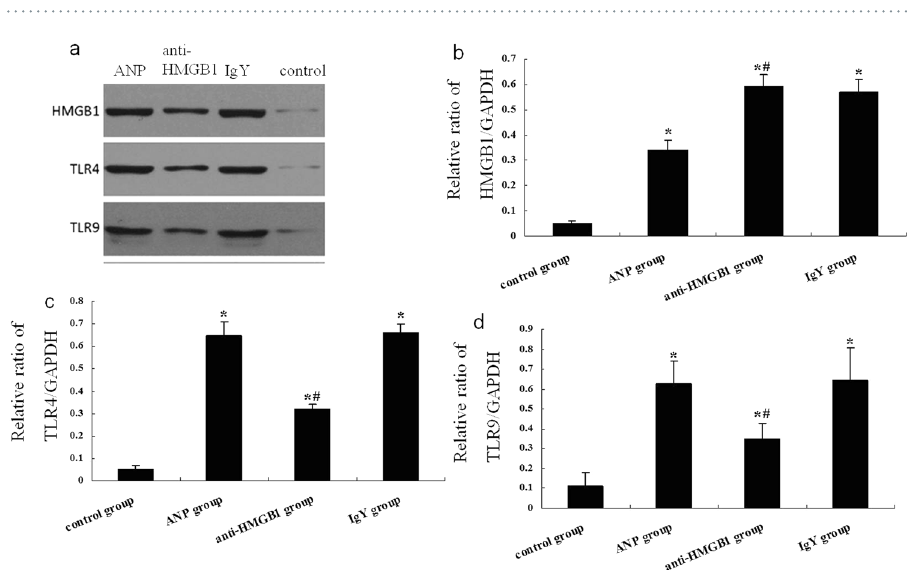
Figure 8. Anti-HMGB1 antibody treatment suppresses the elevated expressions of TLR4, TLR9 protiens. ( a ) Western blot showed the expression of HMGB1, TLR4, TLR9 proteins in ileal mucosa. GAPDH served as a loading control. ( b ) The relative ratio (Mean ± SD) of HMGB1/GAPDH. ( c ) The relative ratio (Mean ± SD) of TLR4/GAPDH. ( d ) The relative ratio (Mean ± SD) of TLR9/GAPDH. * P < 0.05 versus control group. # P < 0.05 versus ANP